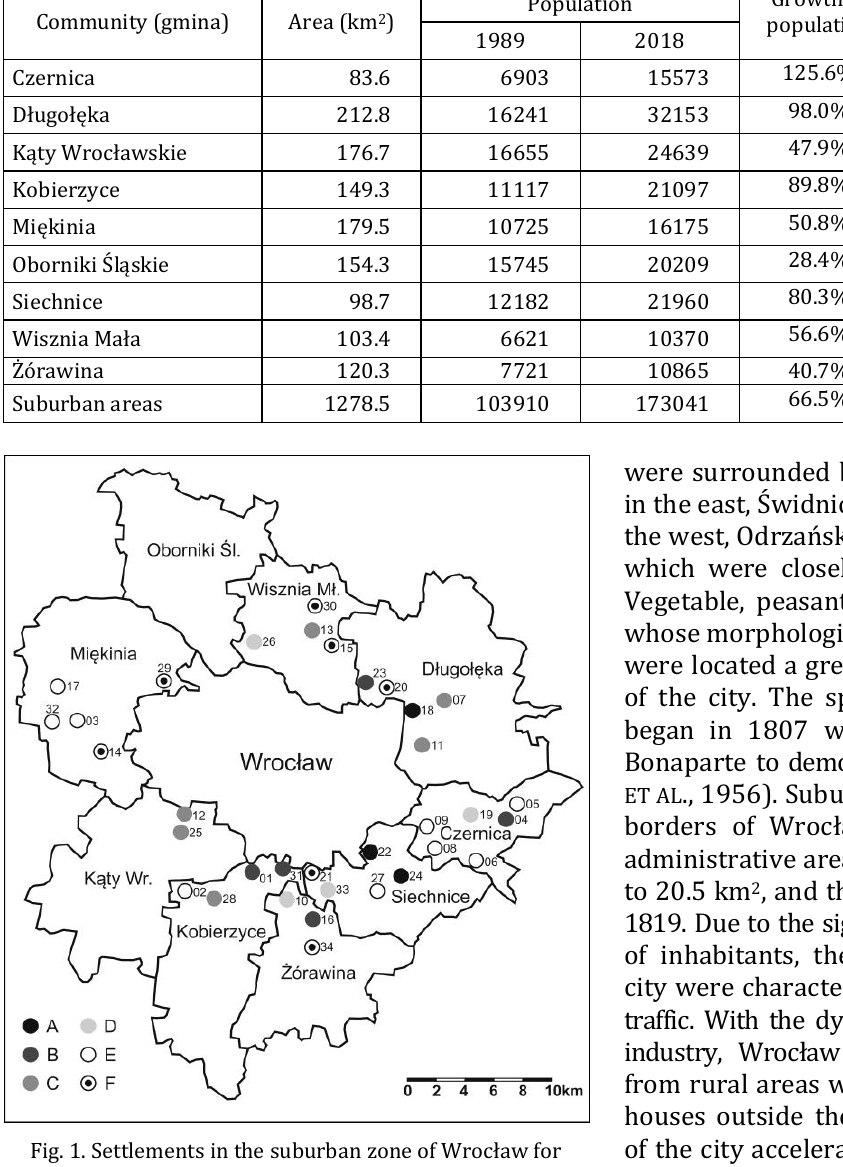
Table 1. Basic data about communities in suburban zone of Wrocław Community (gmina)